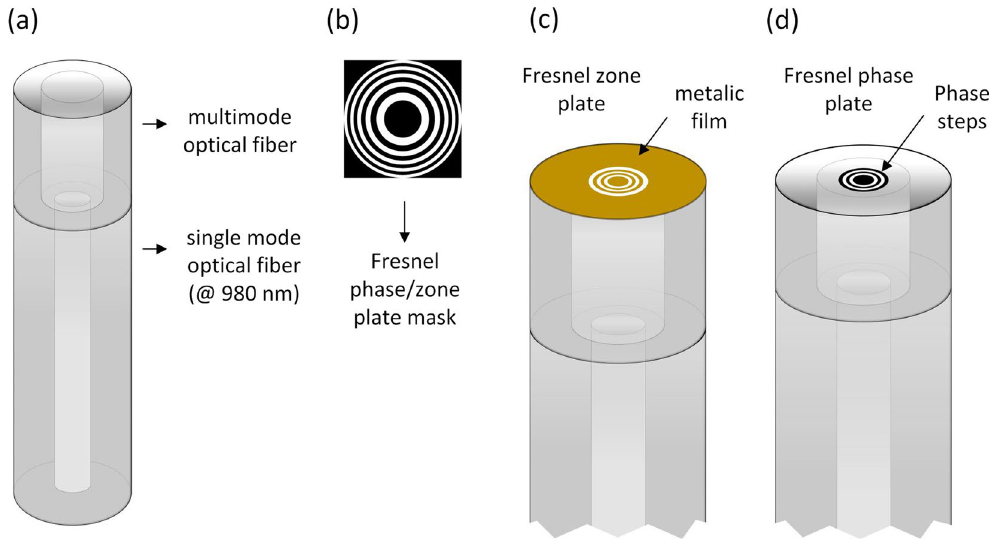
Figure 1. ( a ) optical fibre probe design composed by the SM fibre and the MM segment; ( b ) Fresnel phase/zone plate characteristic ring structure; ( c ) Fresnel zone plate on the tip of the optical fibre (coated with 20 nm Pt film); ( d ) Fresnel phase plate on the tip of the optical fibre (no film).